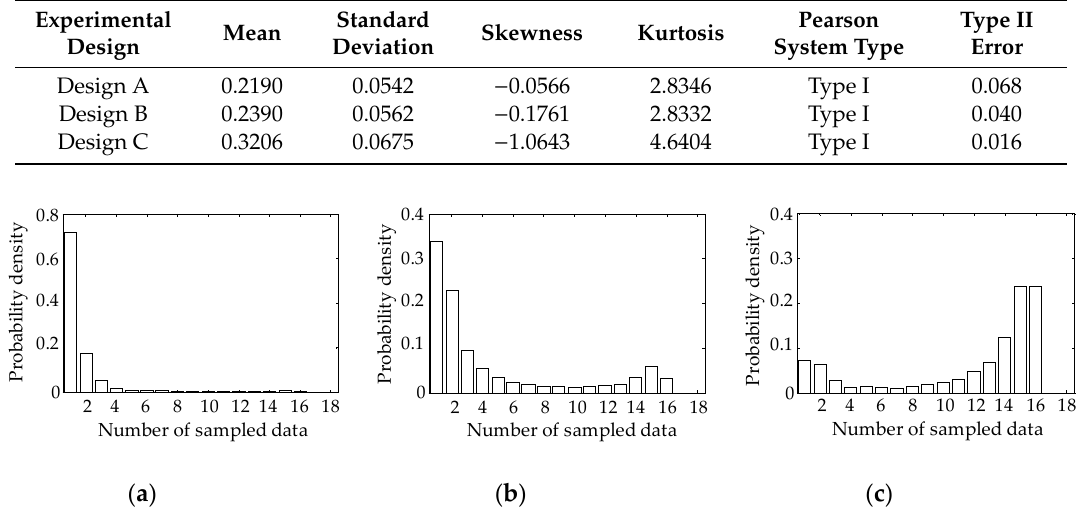
Figure 9. Histogram of the number of sampled data at each operating condition. ( a ) ζ = 3; ( b ) ζ = 5; ( c ) ζ = 7. Table 3. Statistical information of the f u,18 for the three experimental designs.